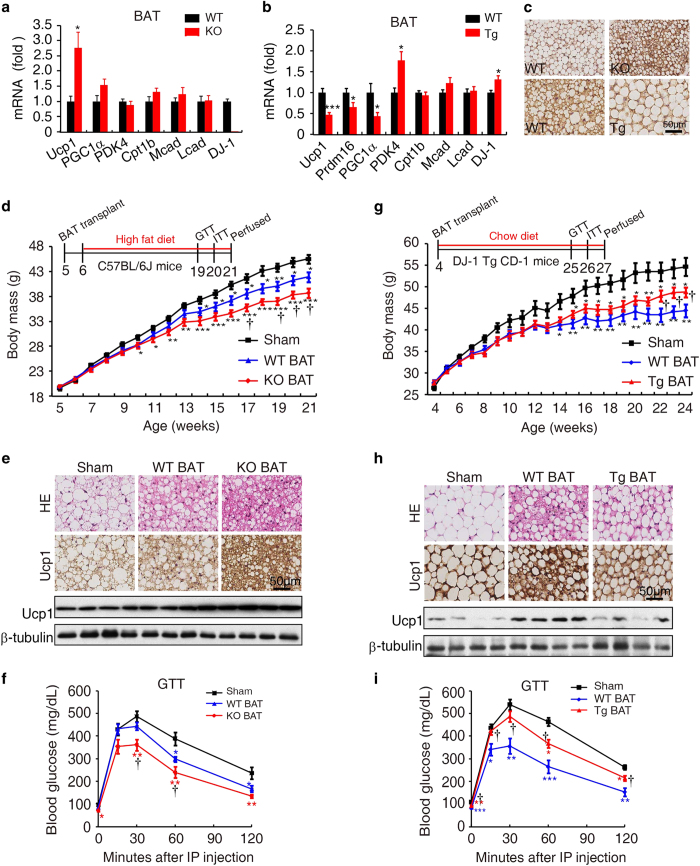
DJ-1 maintains BAT function. (a) Gene expression in BAT from 12-month-old WT and DJ-1 KO mice (n=6 per genotype). (b) Gene expression in BAT from 4-week-old WT and DJ-1 transgenic mice (WT, n=6; TG, n=7). (c) Ucp1 immunostaining of BAT from indicated genotype mice, upper panel tissues from 12-month-old mice and bottom panel tissues from 6-month old. (d) Body mass of mice with sham operation, BAT transplantation from wild-type (WT BAT) and DJ-1 KO (KO BAT) mice (sham, n=11; WT BAT, n=13; KO BAT, n=8). (e) HE (upper panel), Ucp1 immunostaining (middle panel) and immunoblotting (bottom panel) of endogenous BAT from sham operation, WT BAT transplantation and KO BAT transplantation mice. (f) GTT assays of 19-week-old and HFD-induced recipient mice (sham, WT BAT or DJ-1 KO BAT). (g) Body mass curve of the receiver mice of WT BAT or Tg BAT transplantation or sham (n=6 per group). WT BAT or Tg BAT was transplanted subcutaneously with the BAT from wild type or DJ-1 transgenic mice. (h) HE (upper panel), Ucp1 immunostaining (middle panel) and immunoblotting (bottom panel) of the endogenous BAT from the groups indicated. (i) GTT assay results for 25-week-old DJ-1 transgenic mice transplanted with BAT. (Data are shown as the mean±s.e.m. NS, non significant, *P<0.05, **P<0.01, ***P<0.001 in comparison with sham, †P<0.05, ††P<0.01 in comparison with WT BAT, determined using the two-tailed Student’s t-test).